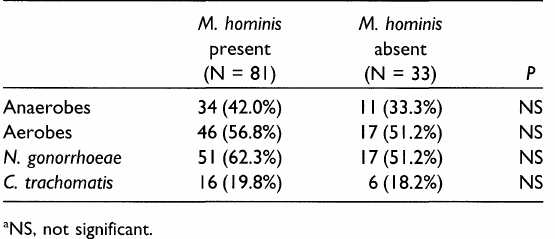
TABLE 5A. M. hominis in endometrical cultures at follow-up visits